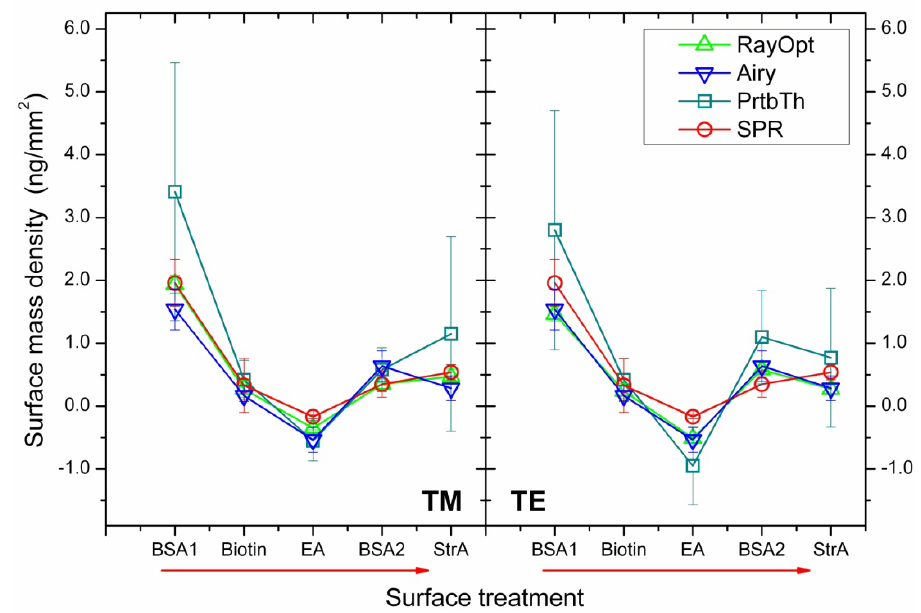
Figure 6. Surface mass densities adsorbed in the different steps of the biomolecular adsorption experiment as determined by SPR and the WGM sensor. For evaluation of the WGM sensor data ( cf., Table 1), three different models were applied: RayOpt—ray optics model, Airy—Airy model, PrtbTh—perturbation